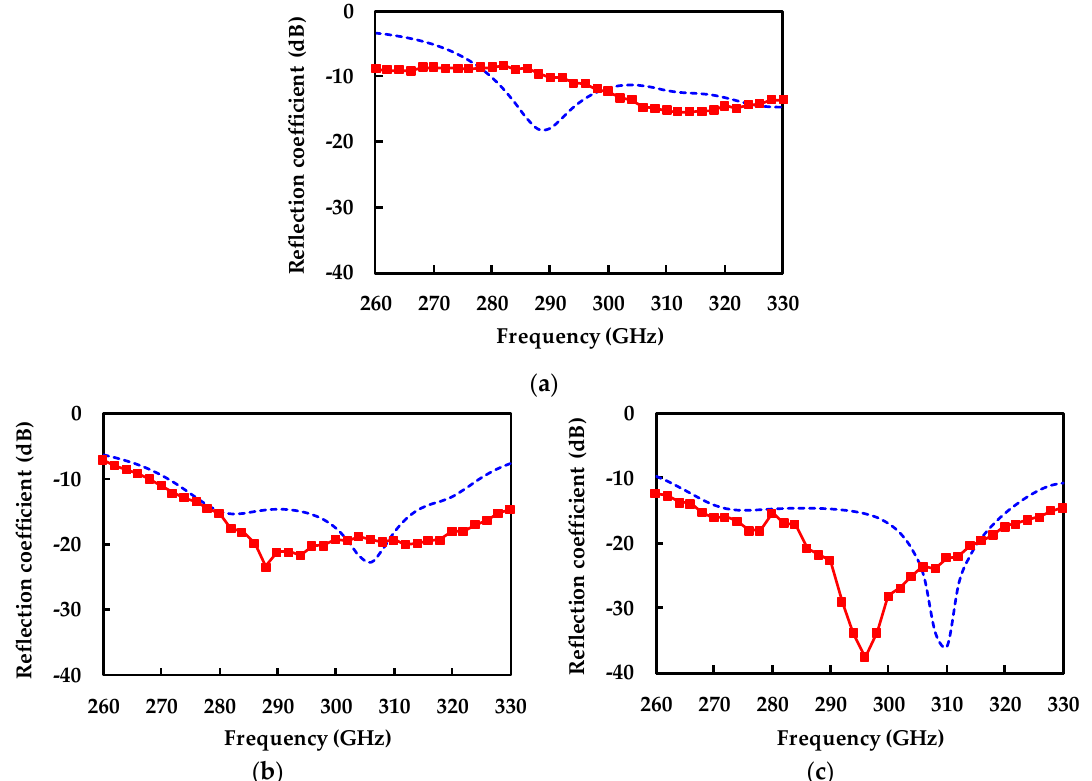
Figure 10. Measured and simulated reflection coefficients of fabricated on-chip antenna (dashed: simulation, squared: measurement). ( a ) Antenna element. ( b ) The 1 × 2 antenna array. ( c ) The 2 × 2 antenna array.